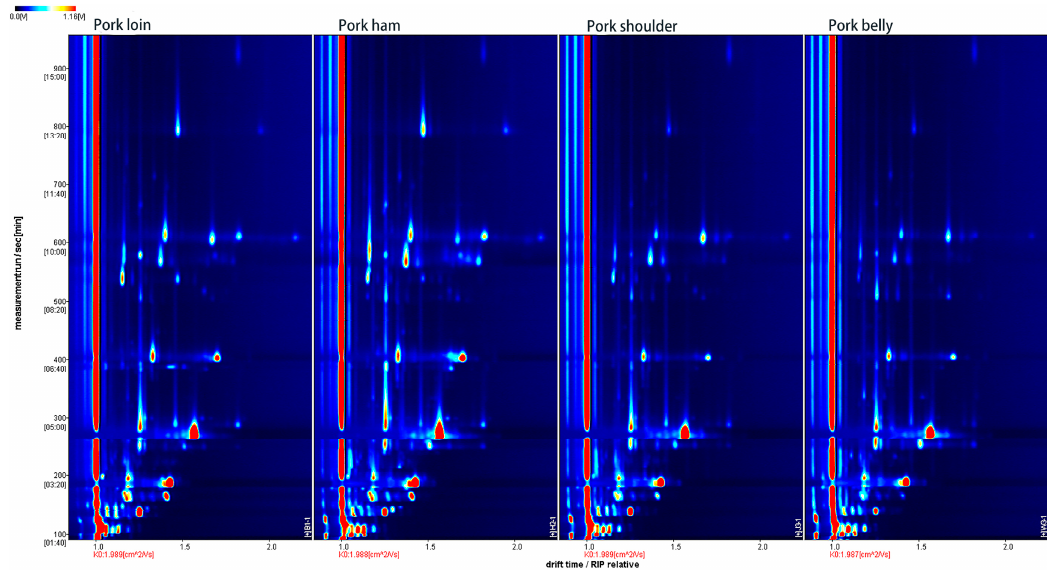
Figure 1. Two-dimensional GC-IMS spectra of volatile organic compounds in four muscles of pork.